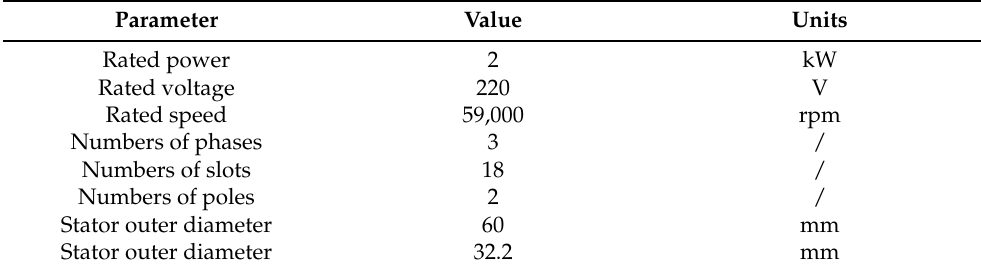
Table 2. Material Properties Comparison.